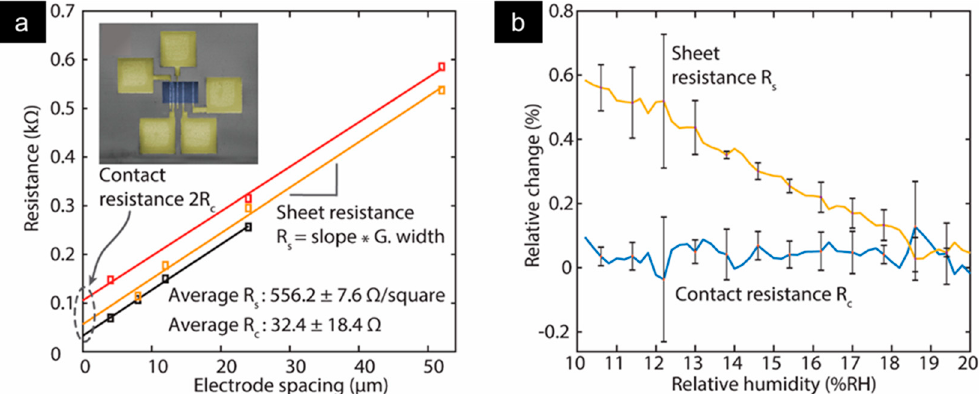
Figure 9. ( a ) Extraction of contact resistance of three transmission line model (TLM) devices with chemical vapor deposited (CVD) graphene patches on gold contacts. Extrapolating the linear fit (solid lines) of the measured resistance between the neighboring electrodes yields the contact resistance at the graphene / metal interface. Multiplication of the slope of the fit by the graphene patch results in the graphene sheet resistance. The inset displays a colorized scanning electron microscopy (SEM) photograph of a TLM device with gold contacts (yellow) and covering a graphene patch (blue). ( b ) Relative change in contact resistance and sheet resistance for variation in relative humidity (RH). Solid lines are the average of the three devices with 1 σ error bars.